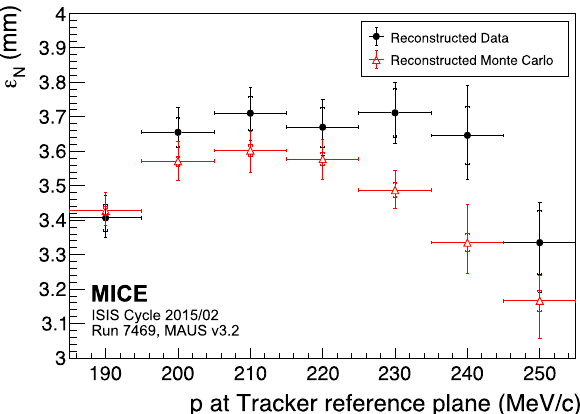
Fig. 9 Normalised transverse emittance as a function of total momen- tum, p ,fordata(black,filledcircle)andreconstructedMonteCarlo(red, open triangle). The inner error bars show the statistical uncertainty. The outer error bars show the quadratic sum of the statistical and systematic